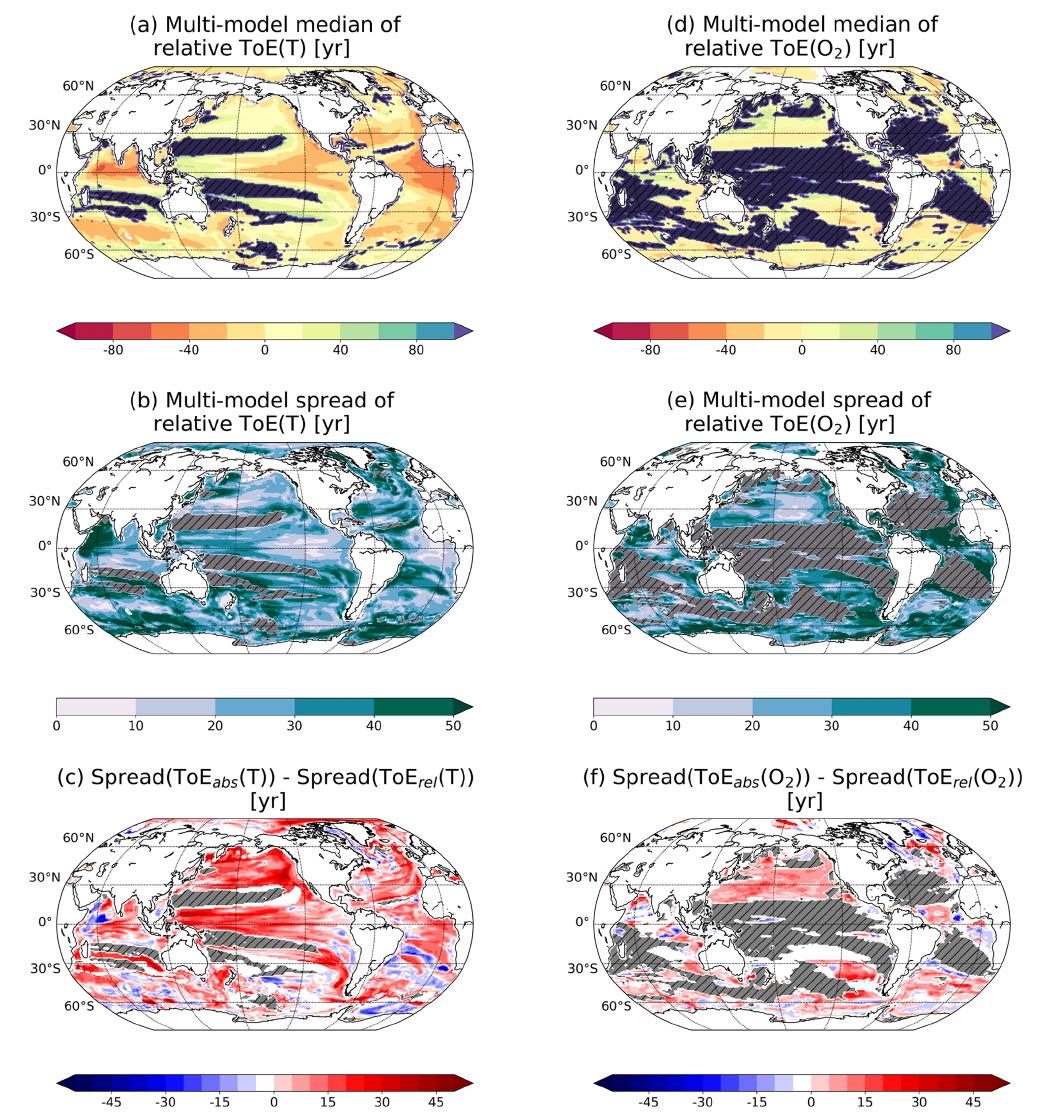
Figure 1. Multi-model median (a, d) and spread (b, e) of relative ToE for temperature (a, b, c) and dissolved oxygen (d, e, f) for the thermocline (200–600m). The spread is computed as the interquartile range. Difference (c, f) between the multi-model spread of absolute ToE estimates with the multi-model spread of relative ToE estimates for (c) temperature and (f) dissolved oxygen. The hatched areas show regions with no emergence for at least three models. The relative ToE estimates are shown for each model in Figs. 2 and 3 and the absolute estimates in Figs. S1 and S2 in the